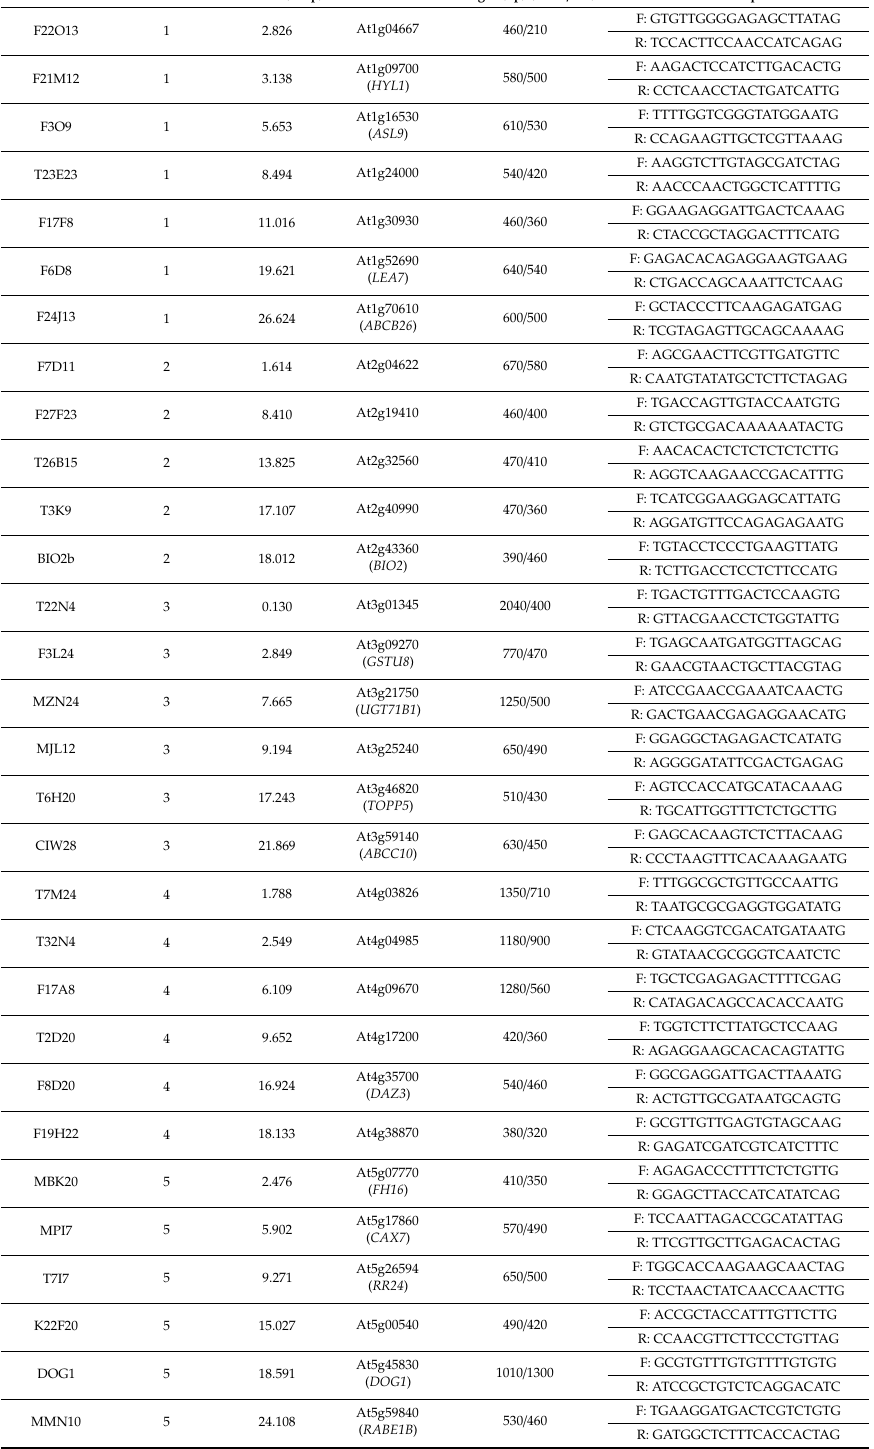
Table 1. PCR primer pair sequences used to examine the 30 InDel markers of this